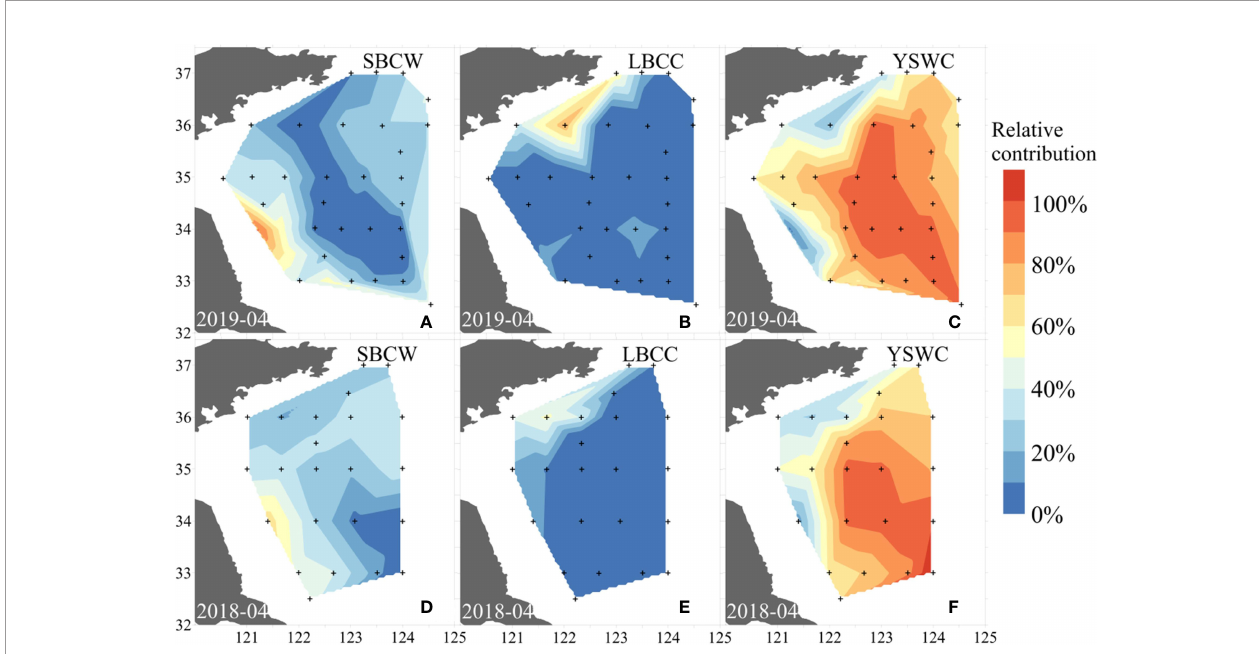
FIGURE 8 | Relative contributions of SuBei Coastal Water (SBCW), LuBei Coastal Current (LBCC) water, and Yellow Sea Warm Current (YSWC) water in the bottom layer of the SYS in April 2019 (A – C) and April 2018 (D – F) .